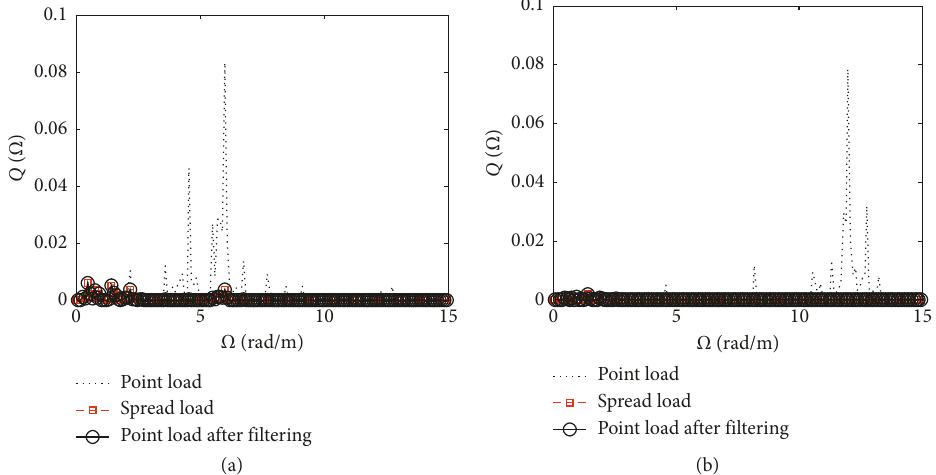
Figure 11: Fourier spectrum of bridge acceleration for the 2nd and the 3rd modes (ML model). (a) The second mode. (b) The third